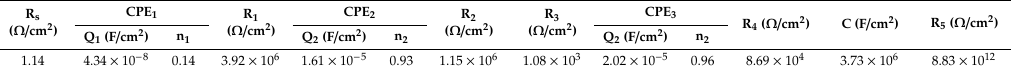
Table 1. Values of electrical element of equivalent